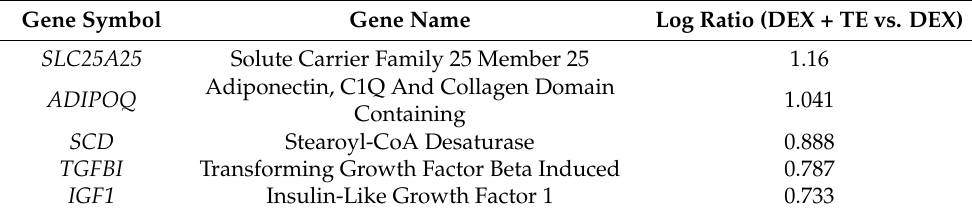
Figure 2. Effects of 2% turmeric extract (TE) supplementation on gene and protein expression of atrophy-related factors in the tibialis anterior muscle of dexamethasone (DEX)-treated mice. ( a ) Gene expression of Fbxo32, Murf1, FoxO1, and FoxO3. ( b ) Protein expression of FBXO32 and MuRF1. ( c , d ) are the correlation between mRNA and protein expression of FBXO32 and MuRF1. The results are shown as the mean ± standard error and statistical analysis was performed by Tukey–Kramer test. The correlation test was performed by Pearson correlation test. Control group: n = 7; DEX and DEX + TE groups: n = 6 each in the PCR experiment and n = 4 in Western blotting. * p < 0.05, ** p < 0.01 vs. Control, # p < 0.05, ## p < 0.01 vs. DEX, N.S.: not significant. Table 2. Gene list of